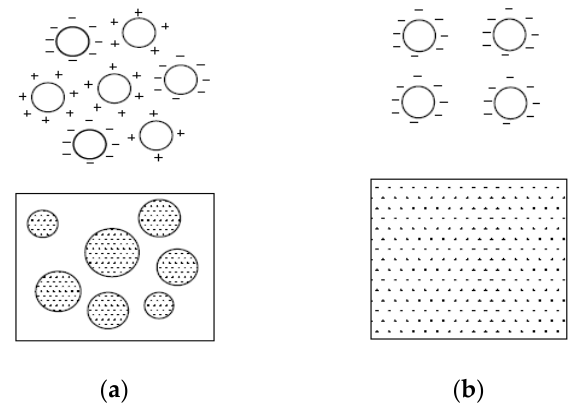
Figure 6. Action of dispersion for graphite nanoparticles; ( a ) schematic diagram of flocculated graphite flakes in aqueous solution; and ( b ) and schematic diagram of uniformly dispersed graphite nanoparticles. Reproduced with permission from [79], ME. Thesis, National University of Singapore, 2012.